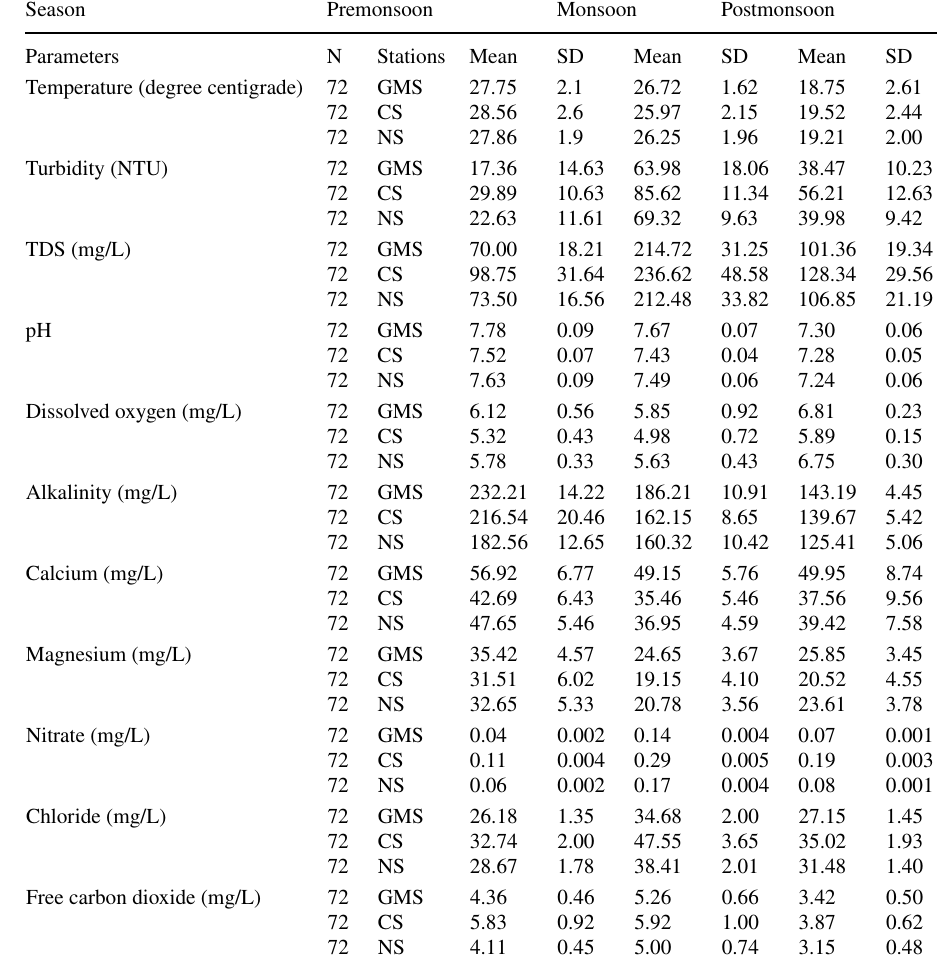
of physicochemical parameters of Gho Manhasa stream (GMS), Chadwal stream (CS) and Nagri stream (NS)